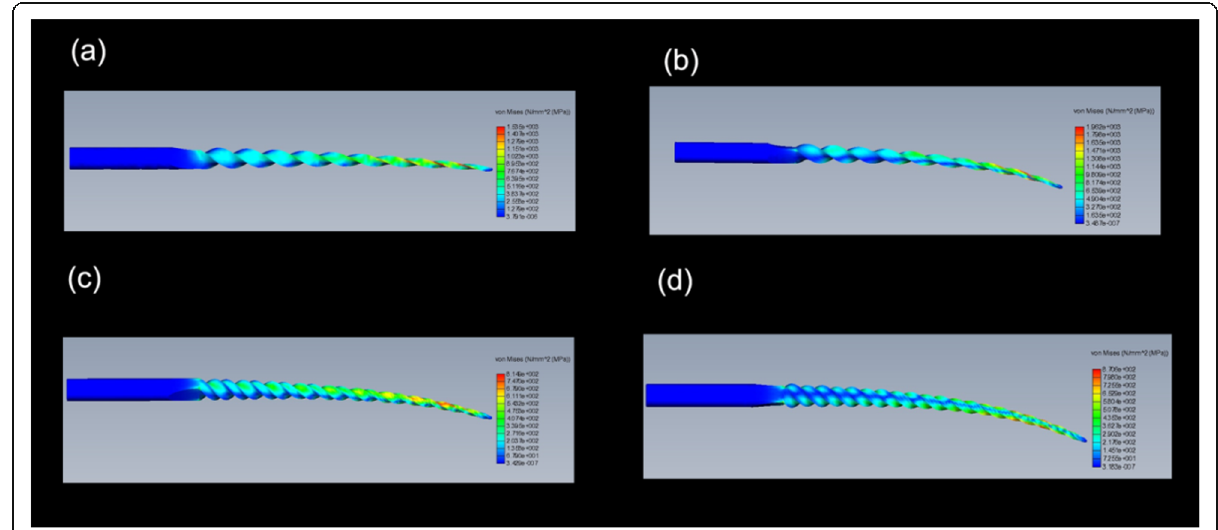
Fig. 3 Stress distribution during bending of different tested file cross sections. a Triangular cs. b Convex triangle cs. c Rectangular cs. d Parallelogram cs